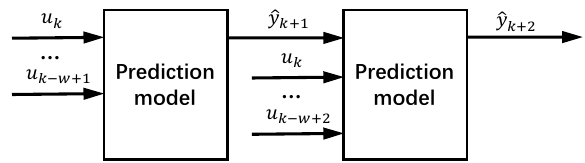
Figure 3. Iterative